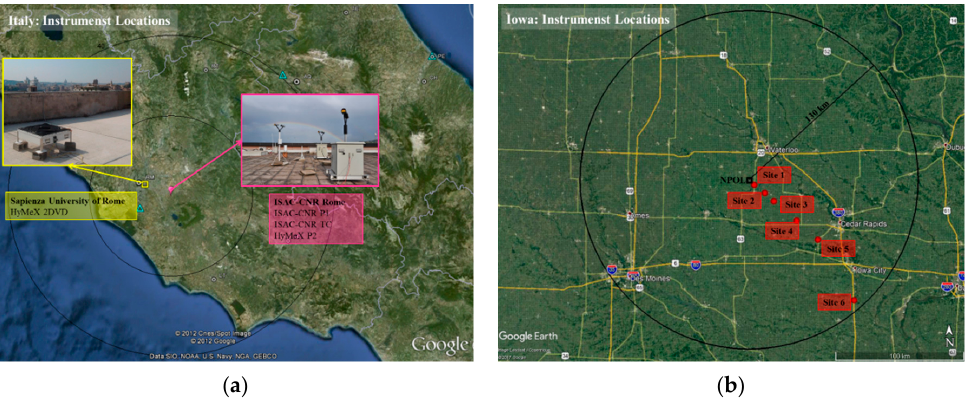
Figure 1. Locations of the disdrometers used in this study in Italy ( a ) and in Iowa ( b ).